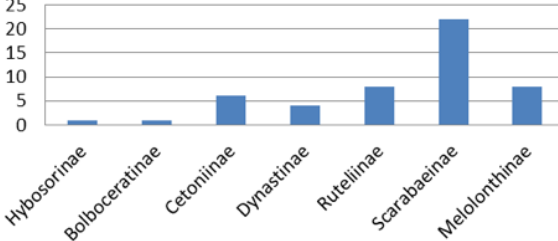
Figire 2. Number of species recorded from the subfamilies from the Western Ghats of